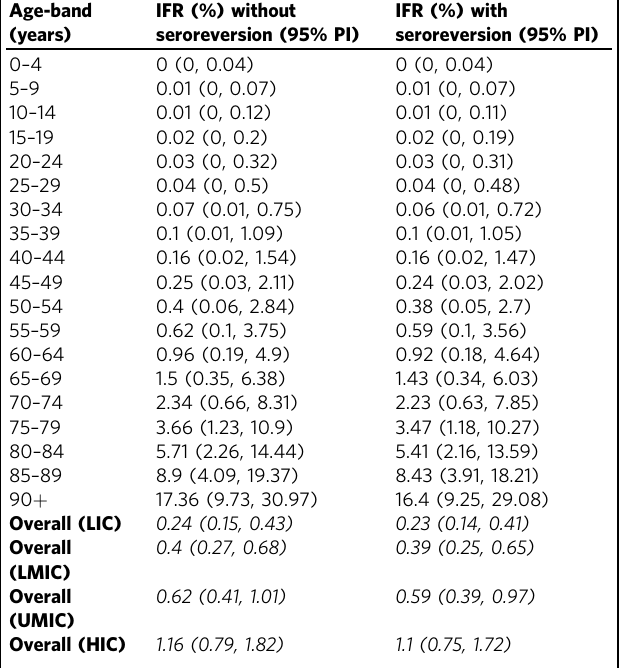
Table 2 Pooled estimates of the infection fatality ratio. Age-band (years)